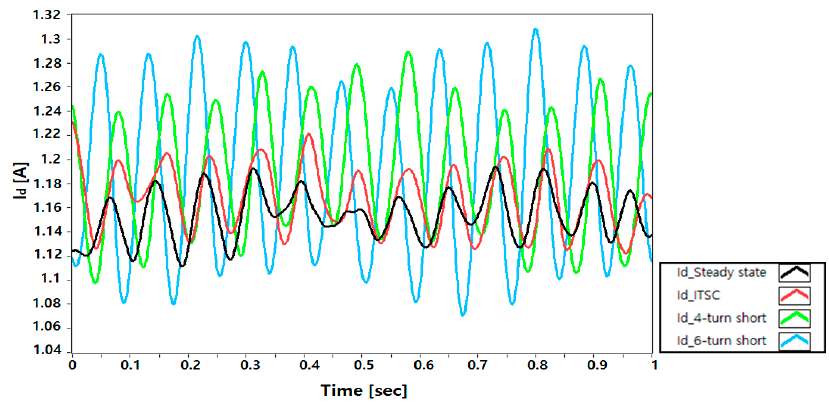
Figure 12. D-Q synchronous coordinate system according to turn short circuit at no load.